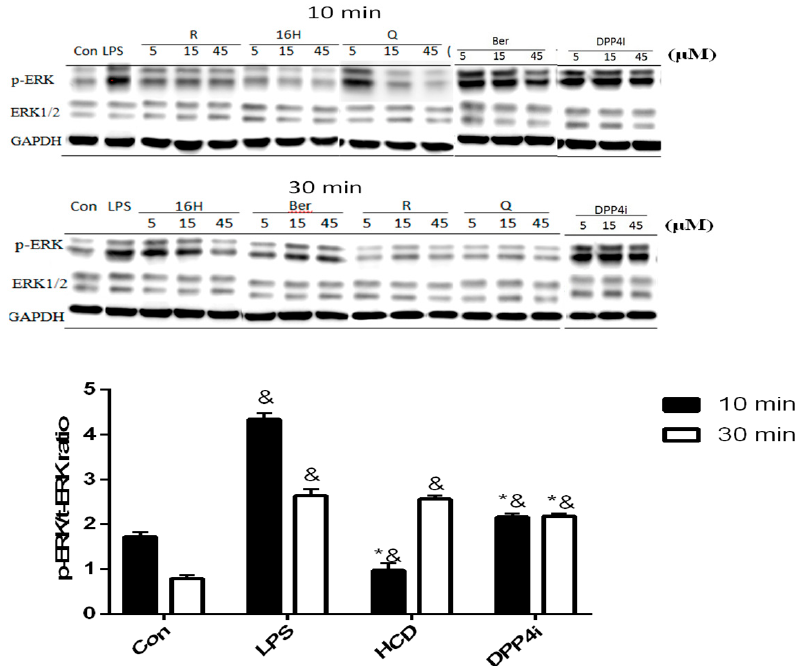
Figure 3. ERK phosphorylation change after selected natural compounds’ treatment. Myocyte were stimulated by LPS and then treated with, 16-hydroxycleroda-3,13-dien-15,16-olide (HCD & 16H) and sitagliptin (DPP4i) for 10- and 30-min. Ratio of phosphorylated and total ERK levels were detected by Western blotting and normalized with GAPDH. All data were mean ± SD from three independent experiments. * p < 0.05 was marked in the column significantly different to LPS and “&” with DPP4i .